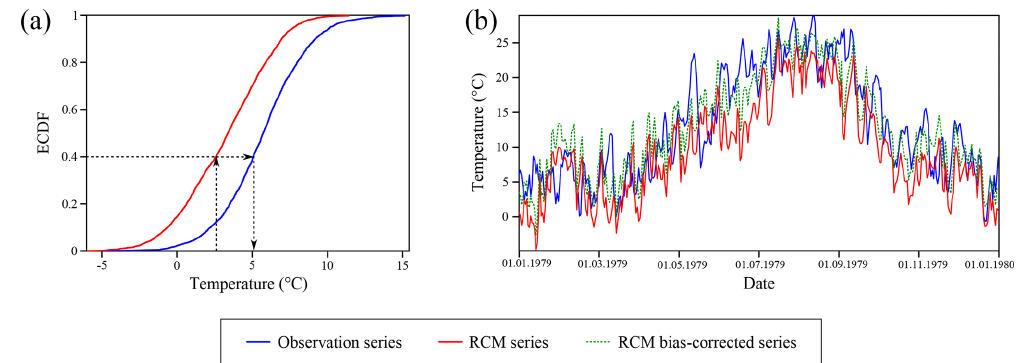
Figure 5. (a) Example of ECDF of the observed (blue) and the modelled CP3 (red) daily temperature series and bias correction using the eQM technique: the ECDF of the simulated series (red) is shifted to match with the observed ECDF (blue). (b) Time series of daily temperatures for the observed (blue) and the CP3 modelled (red) datasets and bias-corrected series (green, doted line) for the year